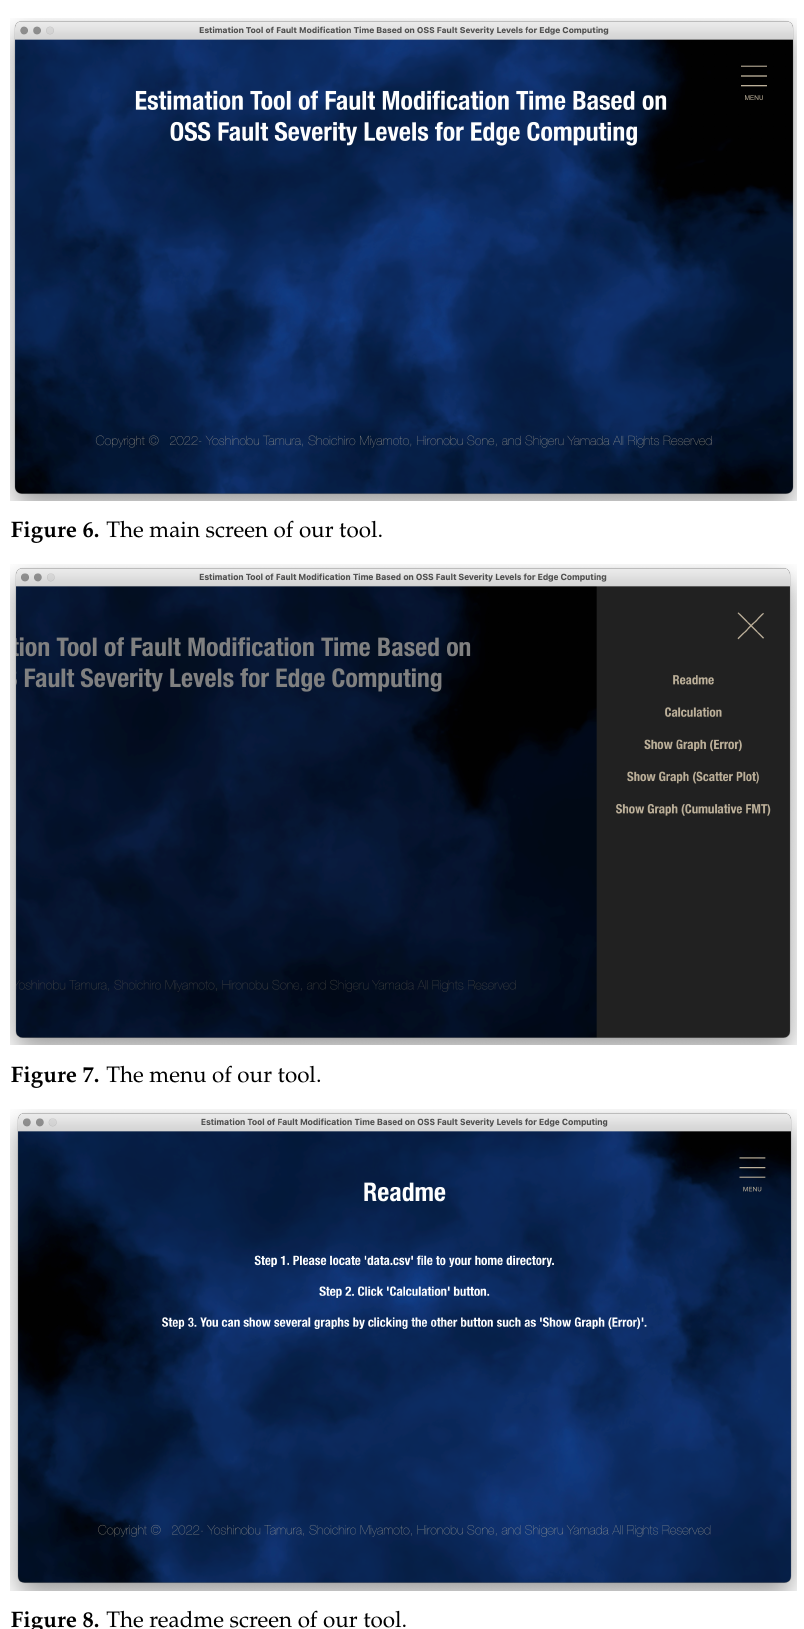
Figure 8. The readme screen of our